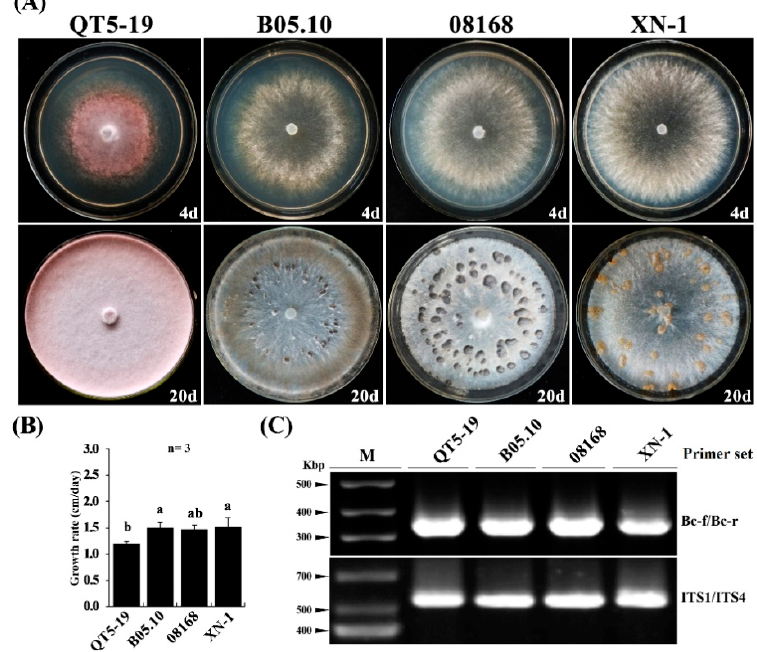
Figure 1. Cultural characteristics of Botrytis cinerea isolates on potato dextrose agar. ( A ) Four-day-old (top) and 20-day-old cultures (bottom) of isolates QT5-19, 08168, B05.10, and XN-1 (20 °C). Note difference in colony color, pink for QT5-19, whereas gray for the other three isolates. Note also difference in sclerotial color, orange sclerotia produced by isolate XN-1, whereas black sclerotia produced by isolates 08168 and B05.10; ( B ) A histogram showing average mycelial growth rates of the four isolates. Means ± S.D. ( n = 4) labeled with the same letters are not significantly different at p > 0.05; ( C ) PCR-based identification of QT5-19 using the B. cinerea -specific primer set Bc-f/Bc-r and the universal primer set ITS1/ITS4. Isolates 08168, B05.10, and XN-1 of B. cinerea were used as